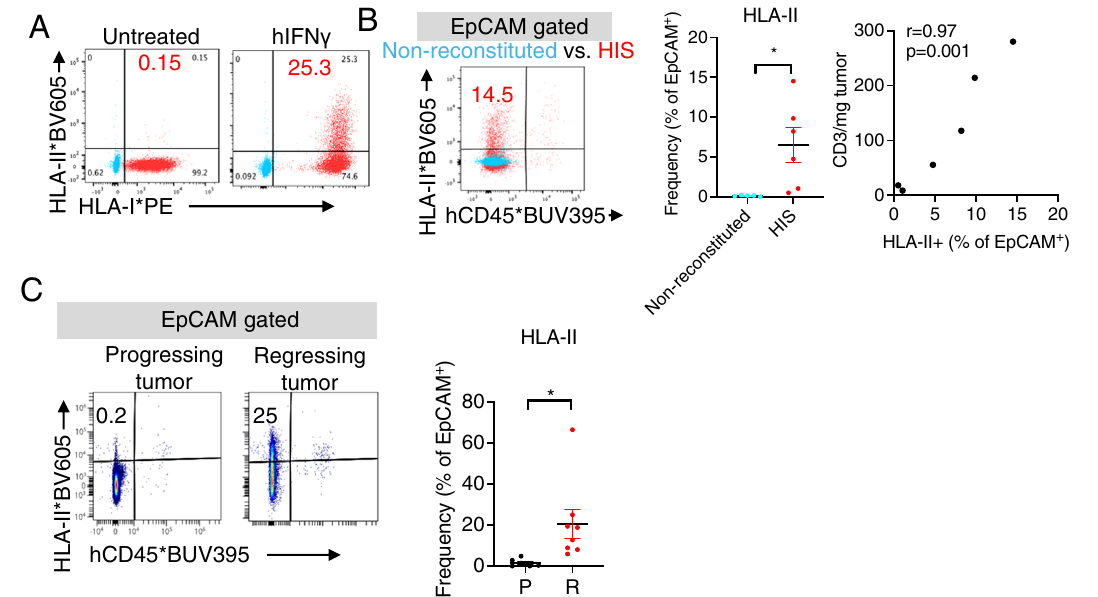
Fig. 3 Tumor control is associated with HLA-II expression on HT-29 tumors. A HLA-I and II expression on cultured HT-29 tumor cells treated with human IFN γ at 10 ng/ml for 16 hours. Untreated cells were used as control. B HLA-II expression on HT-29 tumors developed in non-reconstituted ( n = 5) or HIS mice ( n = 6) (left) and correlation between tumor HLA-II expression and CD3 cell density of HIS mice (right). The left graph is shown as means ± SEM. * p < 0.05, unpaired t test. Pearson correlation coef fi cient and p value are shown on the right graph. C HLA-II expression levels on progressing ( n = 6) and regressing ( n = 8) tumors. The result is shown as means ± SEM. * p < 0.05, un p aired t